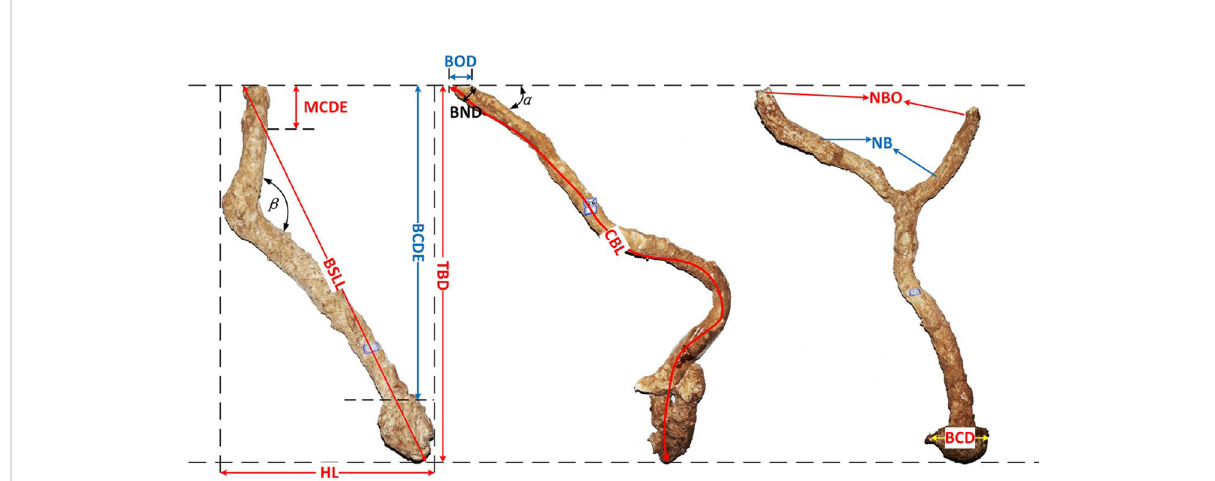
FIGURE 2 Burrow morphology nomenclature of H. tientsinensis. TBD, total burrow depth; BOD, burrow opening diameter; a , ground angle; CBL, curve burrow length; HL, horizontal length; b , mid angle; BND, burrow neck diameter; MCDE, middle chamber depth; BCDE, bottom chamber depth; BSLL, burrow ’ s straight-line length; BCD, bottom chamber diameter; NBO, number of burrow openings; NB, number of